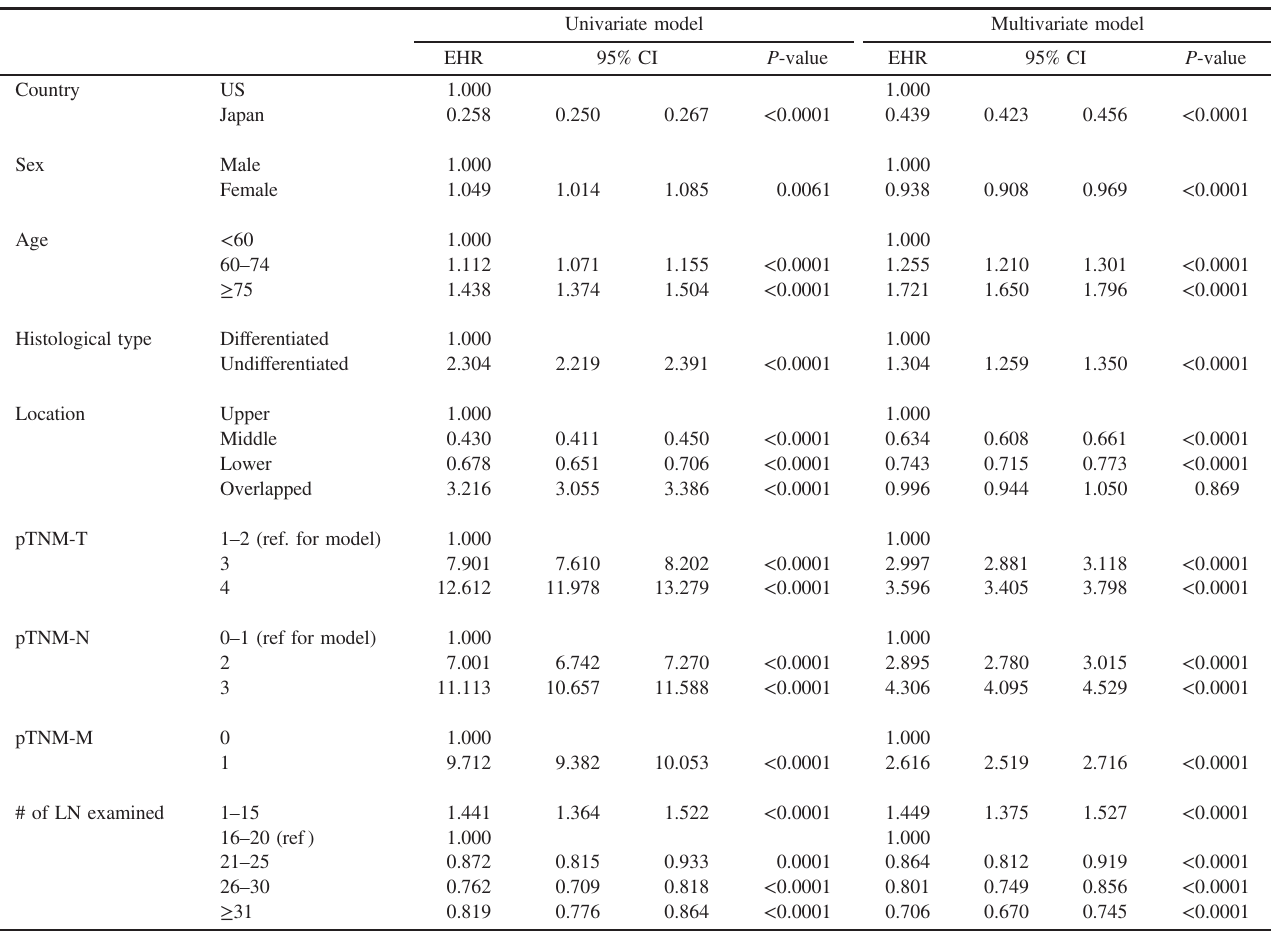
Table 3. Univariate and multivariate analysis using the excess hazard country-speci fi c model Univariate model Multivariate